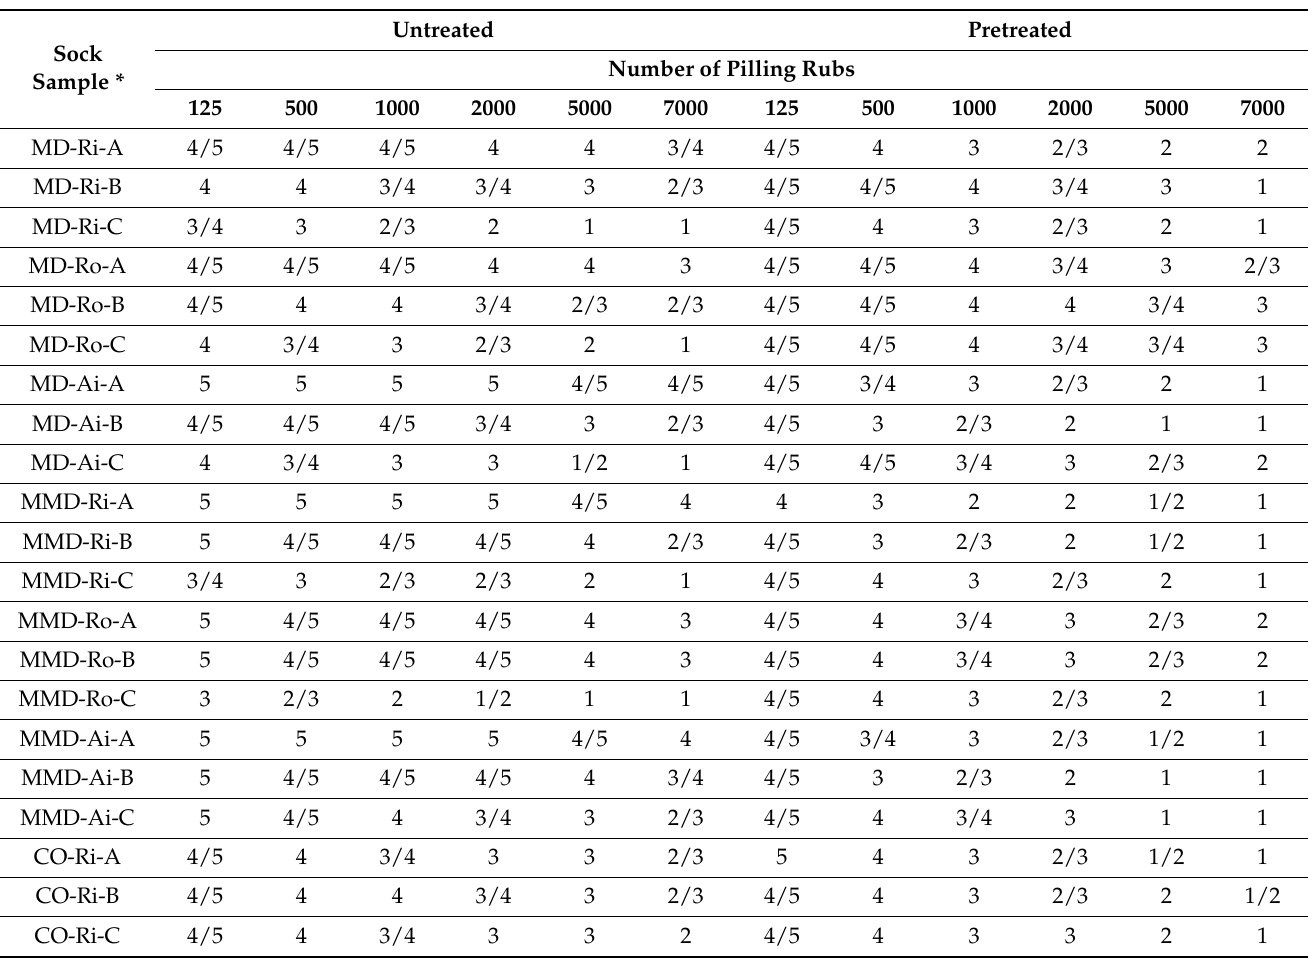
Table 6. Visually assessed propensity to surface pilling in the untreated and pretreated sock plain knits using grades of